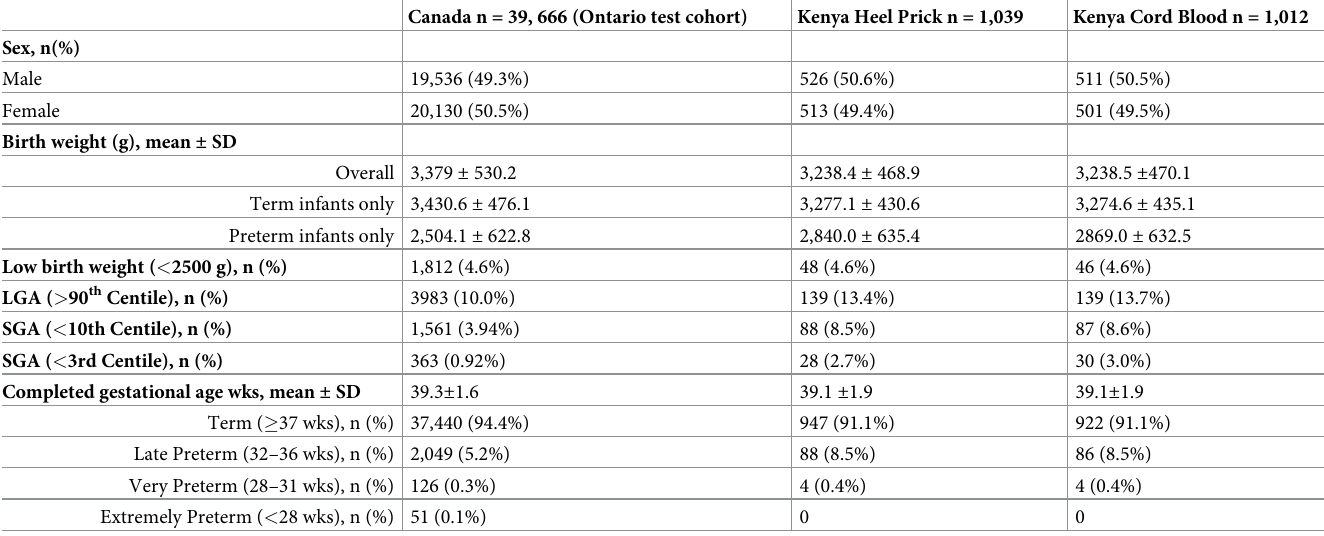
Table 2. Cohort characteristics.